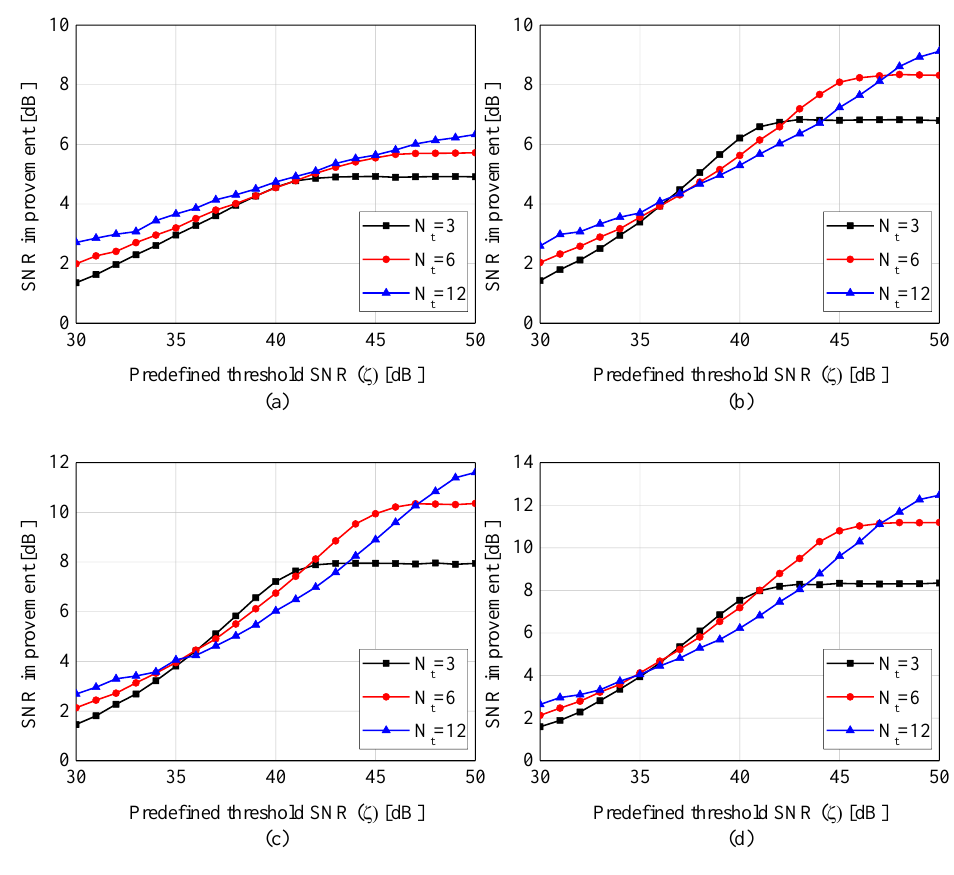
Figure 9. The simulated SNRs of the proposed algorithm versus ζ when ν is set as ( a ) 2 dB, ( b ) 4 dB, ( c ) 8 dB, and ( d ) 16 dB,